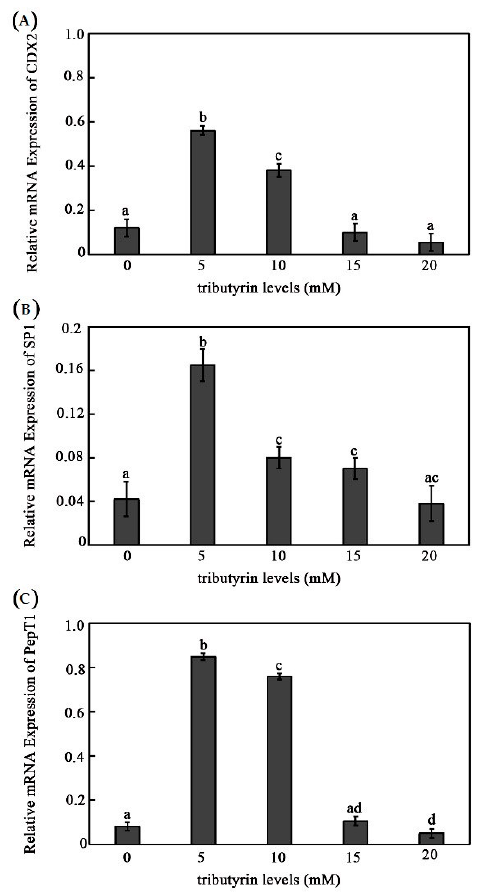
Figure 2. The influence of different concentrations of tributyrin on the expressions of CDX2, SP1, and PepT1 in the intestine cells of grass carp. ( A – C ) The mRNA expressions of grass carp intestinal genes CDX2 ( A ), SP1 ( B ) and PepT1 ( C ). The data represent the mean ± SD. Tukey’s multiple range test was performed, and different letters represent significant differences ( p < 0.05, n = 4 for each treatment with three replicates).